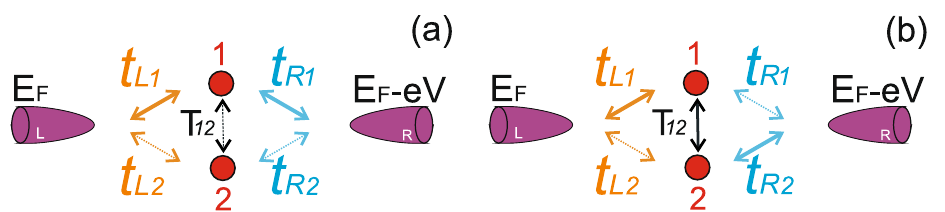
Figure 2. (Color online) Schemes of tunneling between tunneling contact leads and intermediate system formed by two interacting impurities. Changing the ratio between various tunneling amplitudes one gets different regimes. (a) Shows the regime when tunneling between the leads through one of the impurity atoms strongly exceeds tunneling between the leads through the other one, t L 1 , t R 1 >> t L 2 , t R 2 ; (b) demonstrates the regime when tunneling between the impurity atoms is strong and t L 1 , t R 2 >> t L 2 , t R 1 . This is the case of tunneling through two-atom chain. Solid lines demonstrate the main tunneling channels. Dashed lines show the weak tunneling channels. Tunneling between the impurity atoms is described by the amplitude T 12